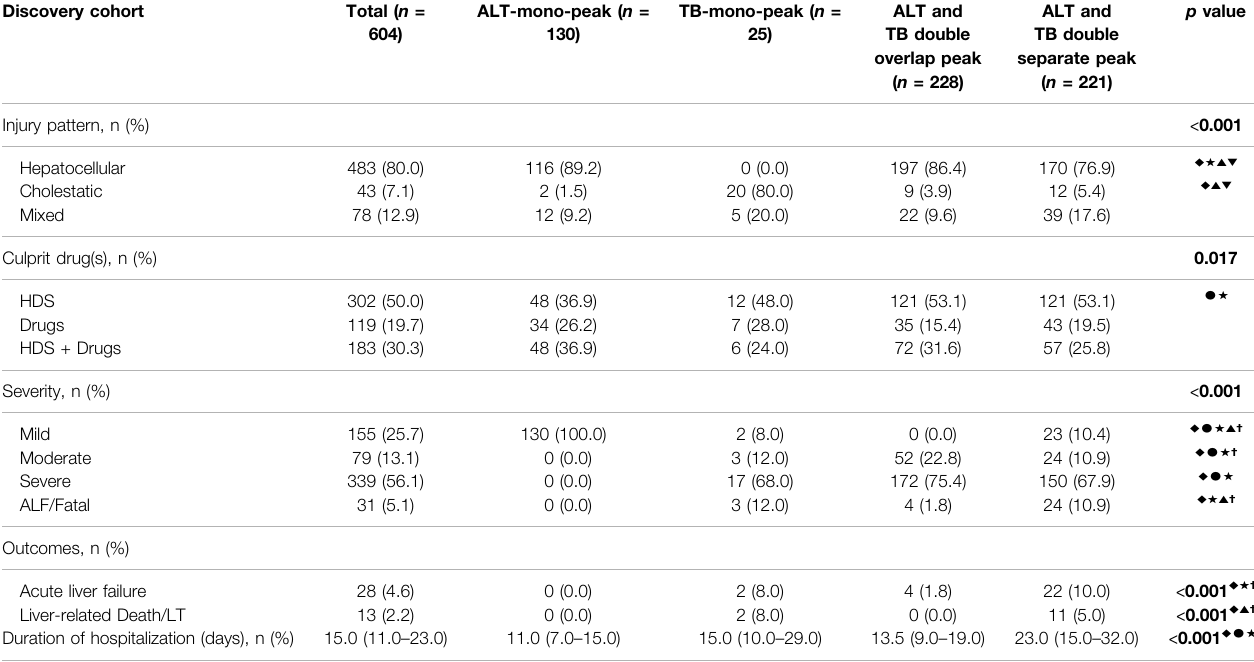
TABLE 2 | Comparison of clinical classi fi cation, severity, and outcomes among the four ALT-TB dynamic evolution patterns in DILI. Discovery